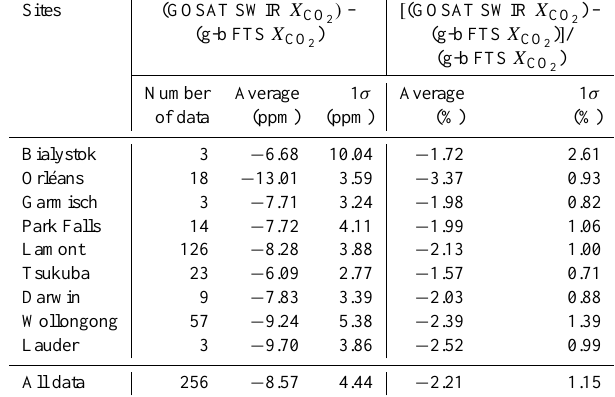
Table A1. Left side: the average and one standard deviation (1 σ) of the difference between GOSAT X CO the nine TCCON sites. Right side: the average and one standard deviation (1 σ) of the difference normalized to g-b FTS X CO in percent). The GOSAT data were retrieved within ± 2 degrees latitude/longitude box centered at each g-b FTS site and the g-b FTS data were the mean values measured within ± 1 h of GOSAT overpass time.